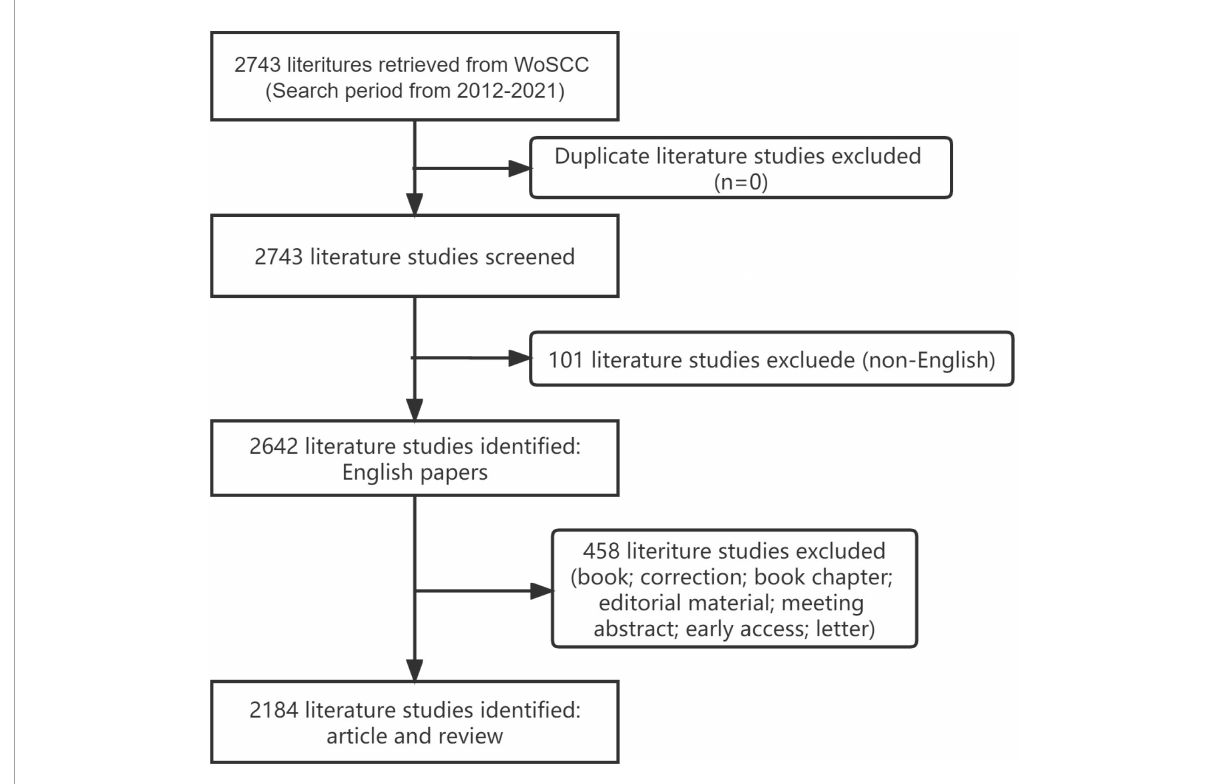
FIGURE1 Flow chart for including and excluding literature